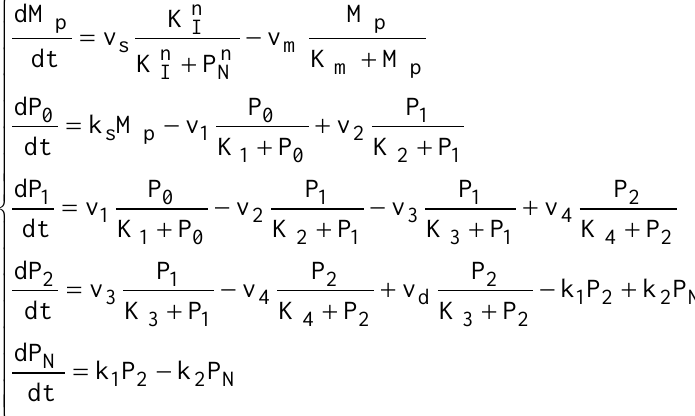
) into the P , P and P ), 0 1 2 ) where it represses the transcription of the N